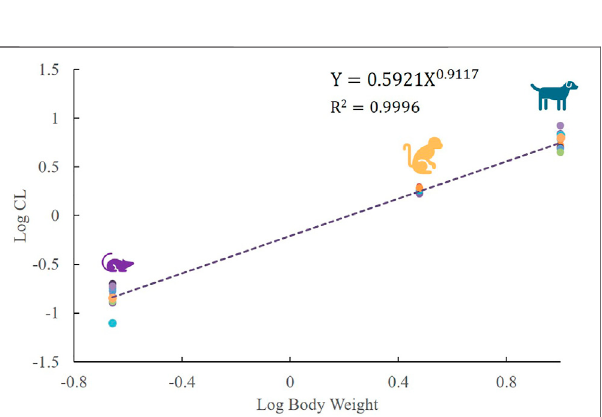
FIGURE 3 | Linear regression analysis of log-transformed plasma clearance for SD rats, beagle dogs, and cynomolgus monkeys versus log- transformed corresponding animal body weight, following IV administration of ST-246 at respective doses (each point represents the individual clearance of each animal, n = 18 for rats and dogs, n = 6 for